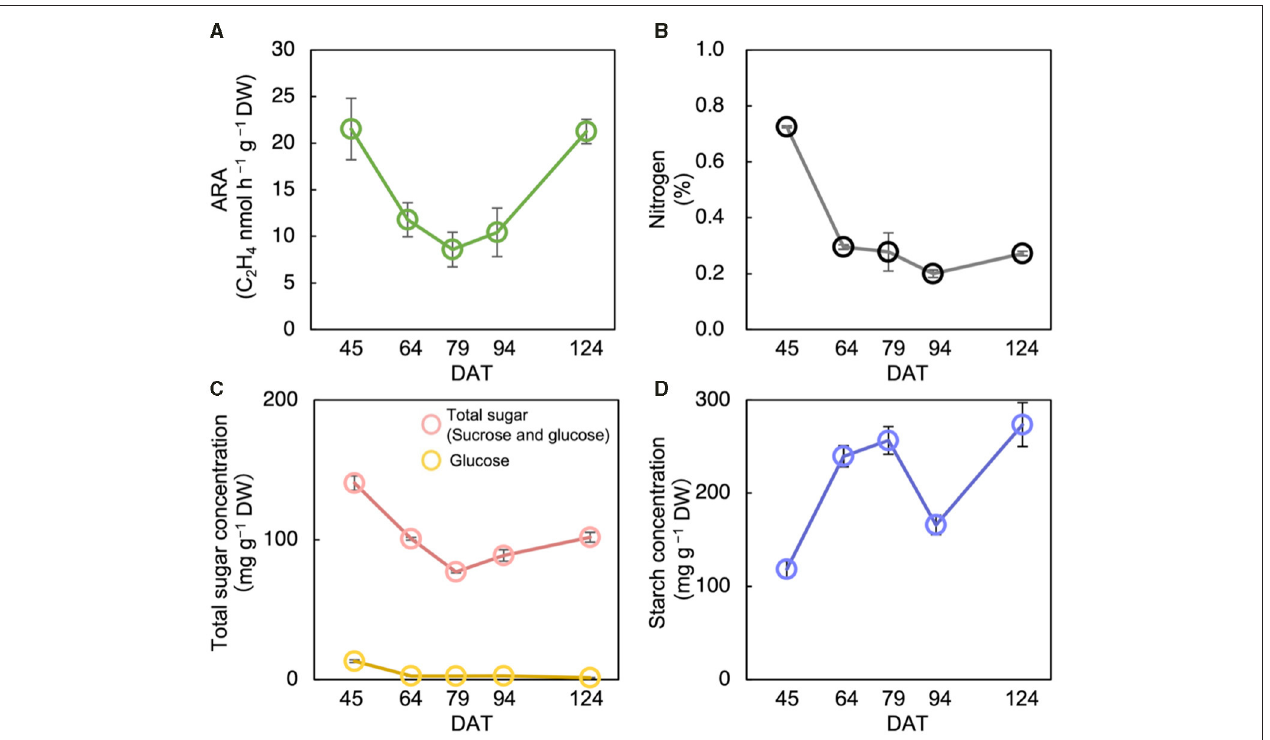
FIGURE 2 | Changes in acetylene reduction activity (ARA) (A) , nitrogen concentration (B) , total sugar (sucrose and glucose) concentration (C) , and starch concentration (D) of stem at different growth stages in Nipponbare at field experiment in 2018. Data for Nipponbare in Table 2 was used for the data at 79 day after transplanting (DAT). The growth stages were the tillering stage on 45 DAT, panicle initiation stage on 64 DAT, heading stage on 79 DAT, ripening stage on 94 DAT, and the maturing stage on 124 DAT. Data are means ± SE ( n = 4 for 79 DAS, n = 3 for 45, 64, 94, and